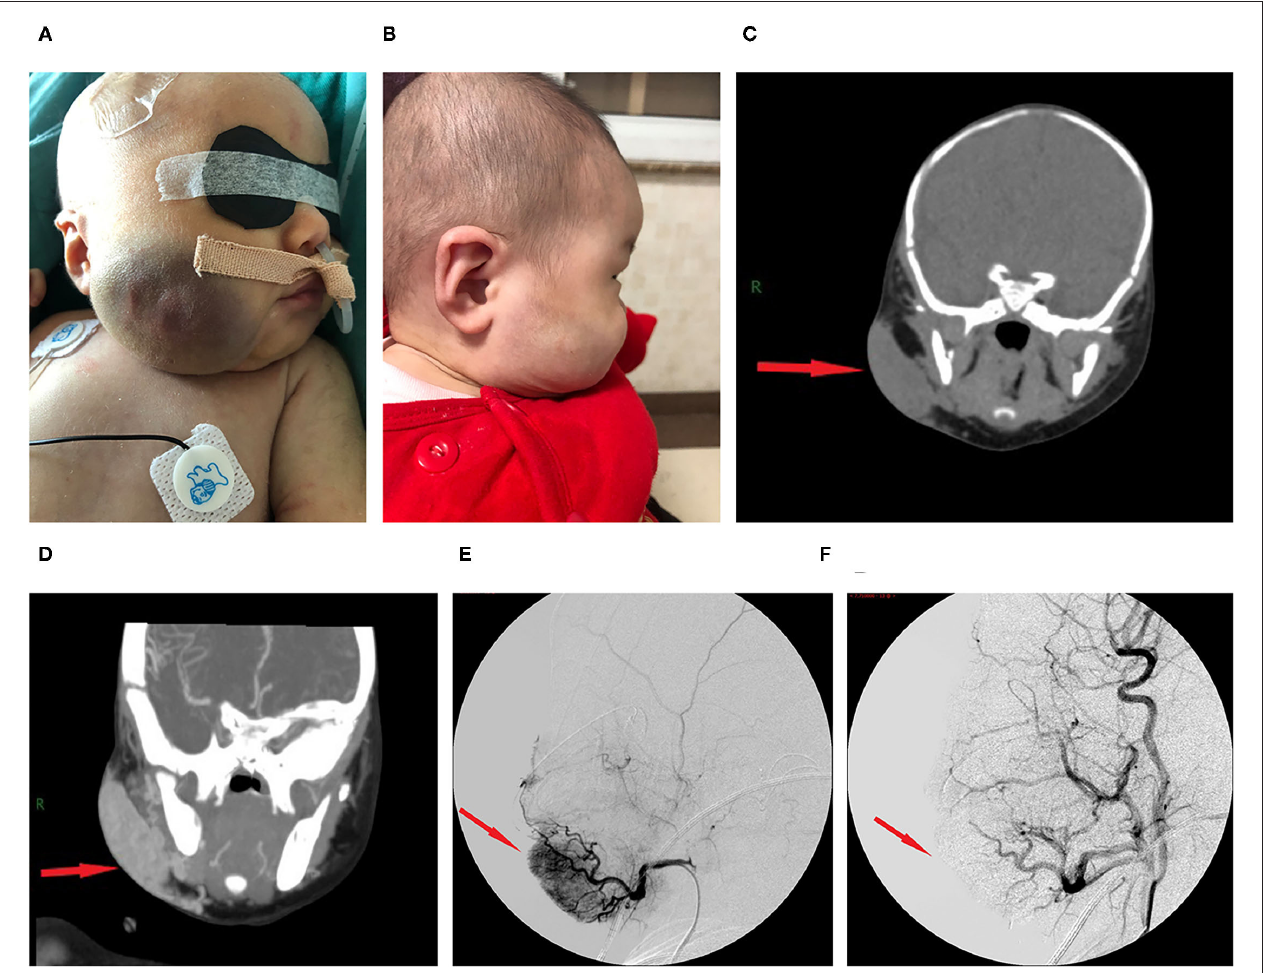
FIGURE 1 | Images from case 8 before and after TAE. (A) A large tumor that measured 7.0 × 6.0 × 3.0cm was seen on the right face. The skin of the tumor was different from the surrounding area, with purple or dark color, obvious swelling, increased tension, slightly elevated but with ill-defined margins, and induration. (B) At 5 months after TAE, the tumor almost involuted completely. (C) CT showed that the lesion was a large soft tissue mass. (D) Contrast-enhanced CT showed obvious arterial phase enhancement inside the mass. (E) CTA showed an abundant tumor blood supply before embolization. (F) After TAE, more than 80% of the tumor-feeding arteries were embolized. CTA, computed tomography–angiography; TAE, transarterial embolization. The red arrow indicates the